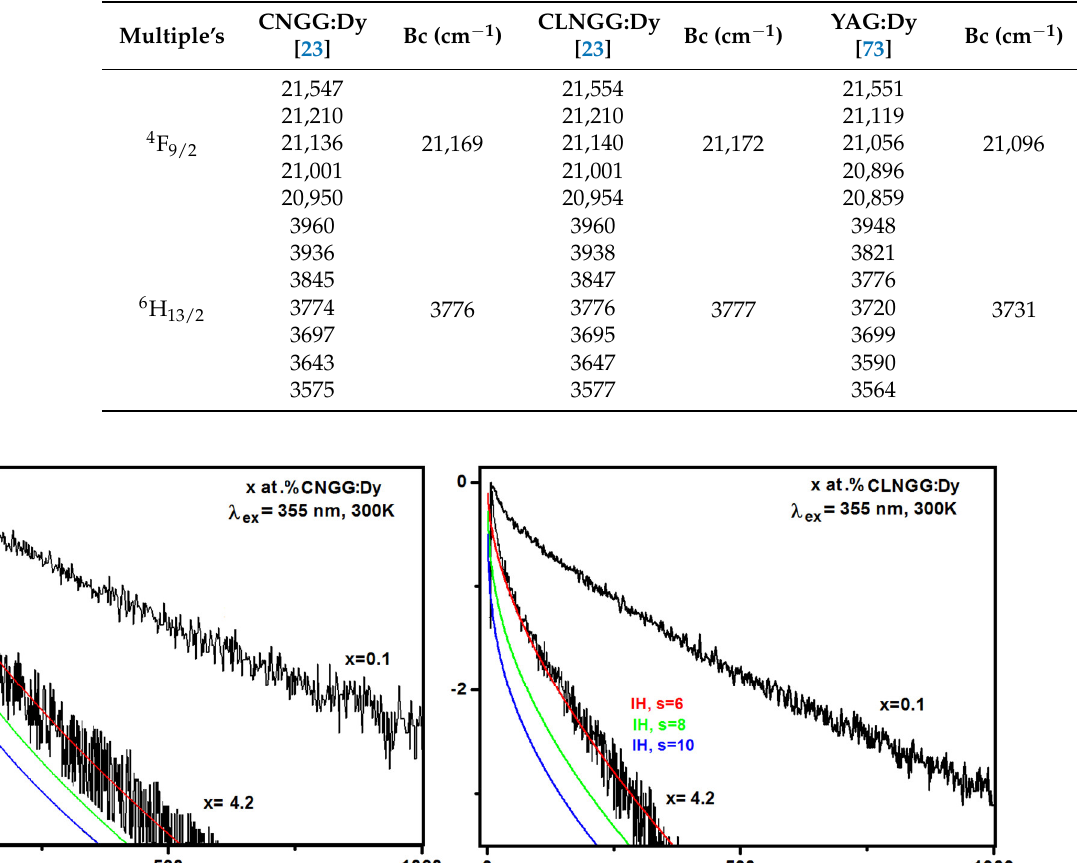
Table 9. Partial energy levels of Dy 3+ ions involved in 4 F 9/2 → 6 H 13/2 yellow laser transition in the CNGG:Dy and CLNGG:Dy crystals.